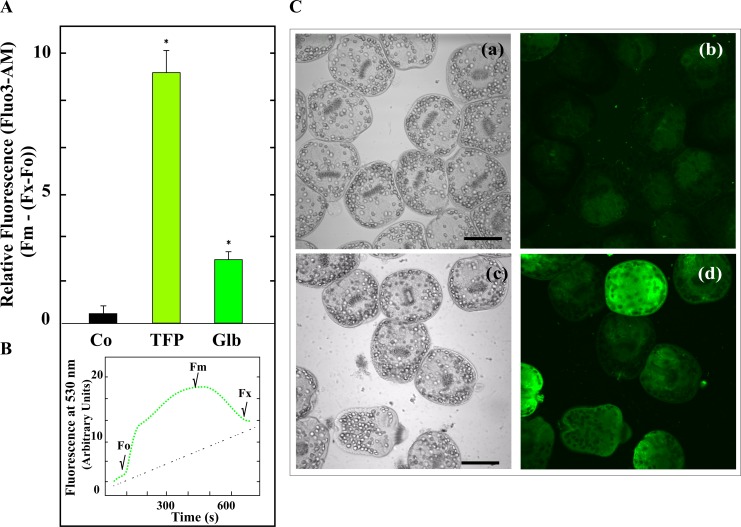
Effect of glibenclamide on intracellular calcium levels in E. granulosus protoscoleces.(A) Protoscoleces were incubated with buffer (Co), 200 μM glibenclamide (Glb) or 10μM trifluoperazine (TFP, positive control) for 2 h and then loaded with Fluo3-AM ester solution in darkness. Data are the mean ± S.D. of three independent experiments. *Statistically significant difference (p < 0.05) compared with control. (B) Free calcium profiles in protoscoleces. Prototype kinetics shown the fluorescence increase with Fluo3-AM. Fo, initial fluorescence; Fm, maximum fluorescence; Fx, final fluorescence. The graphic shows the free calcium decay to baseline within about 600 s with a partial recovery of the initial fluorescence which reveals a strong gradient in the calcium signal during the treatment of this puricellular organism with Glb. (C) Confocal imaging reveled intracellular calcium increase in Glb-treated protoscoleces. Photomicroscopy of light field (a, c) and of fluorescence field (b, d). Control (a, b); protoscoleces treated with Glb (c, d). Bars indicate: 100 μm.